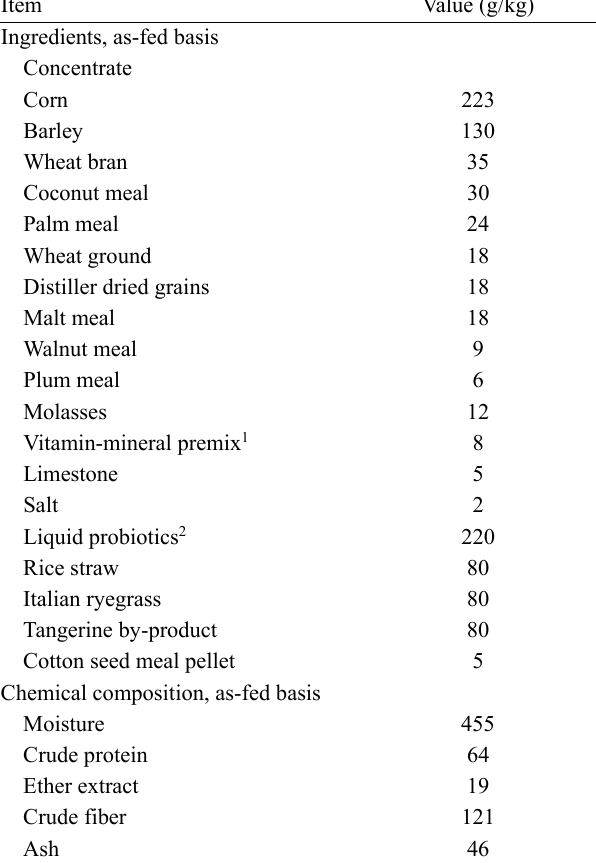
Table 1. Ingredient and chemical compositions of total mixed ration